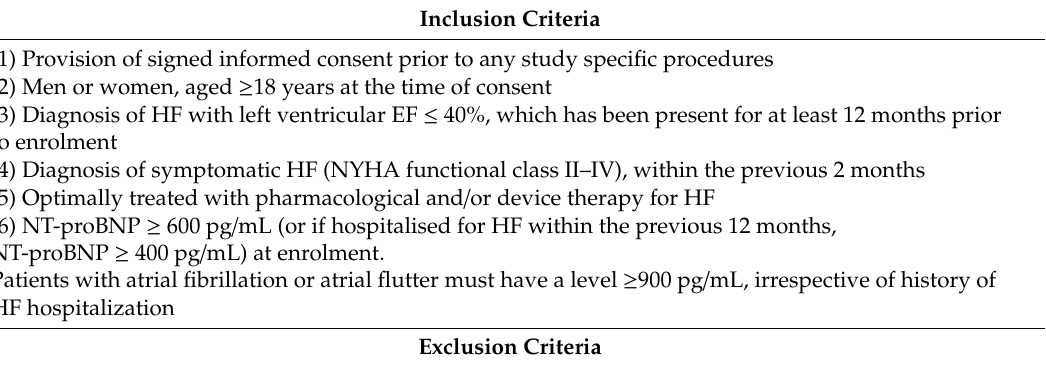
Table 1. Summary of inclusion and exclusion criteria of the DAPA-HF study